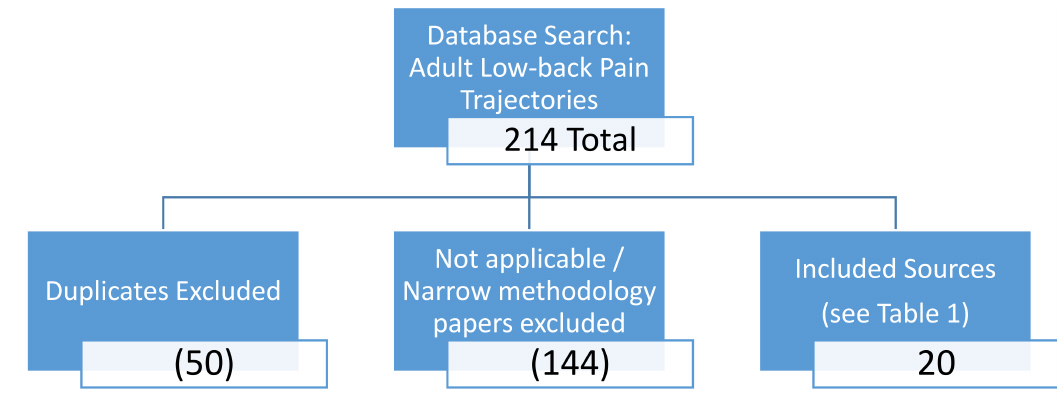
Figure 1. Flow Chart of Background Literature